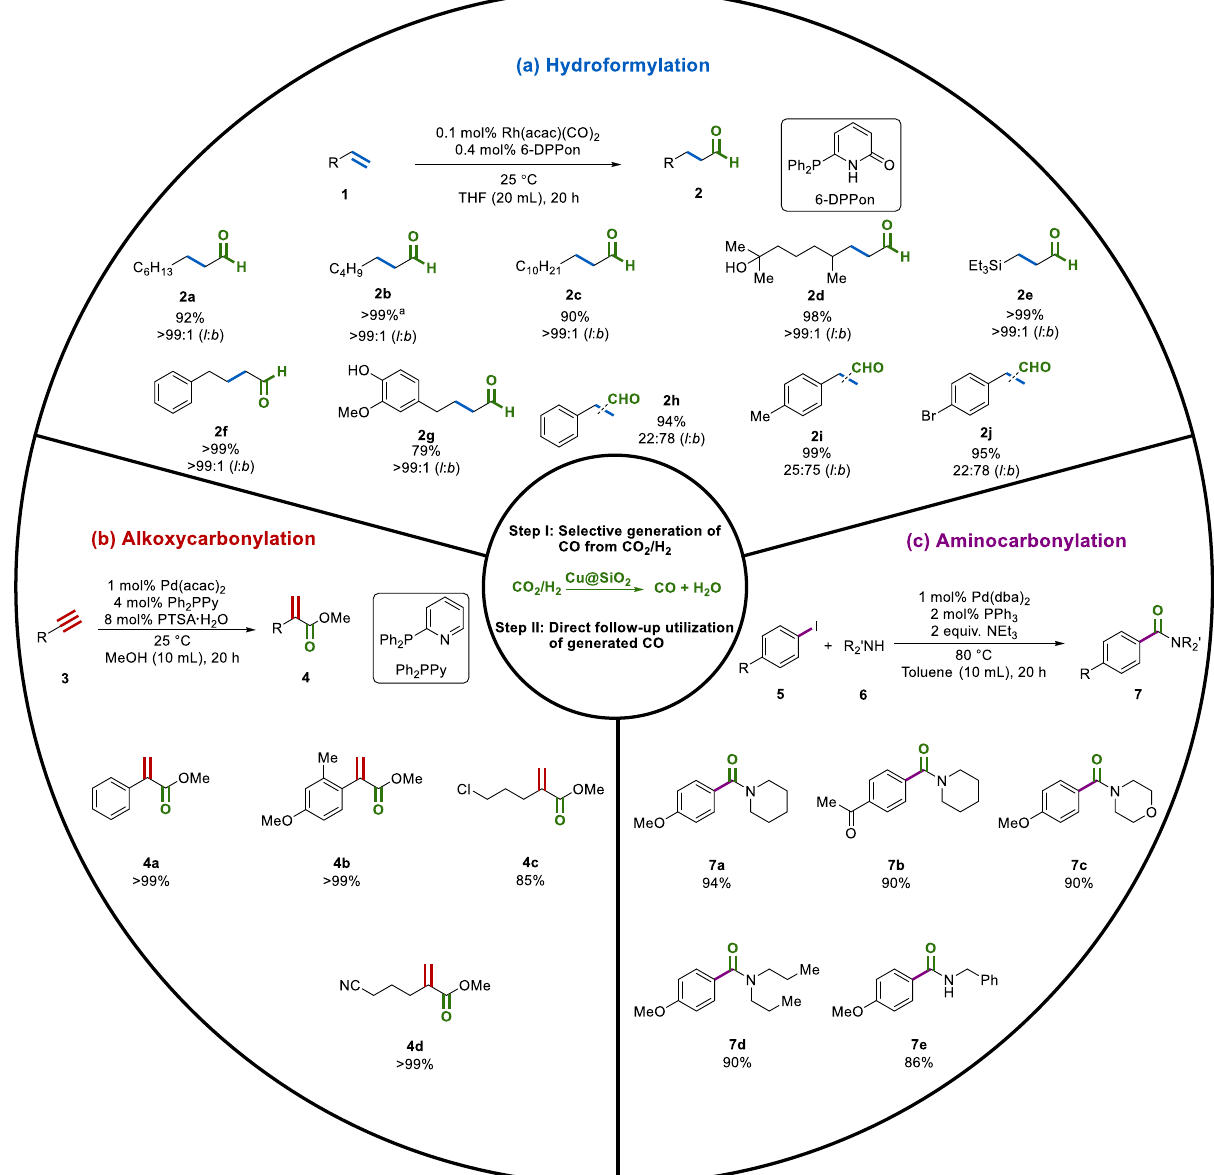
Fig.4|Cu-catalyzedselectiveCO 2 -to-COconversionandthefollow-uputilizationincarbonylationreactions.a Hydroformylationofalkenes. b Alkoxycarbonylation of alkynes. c Aminocarbonylation of aryl